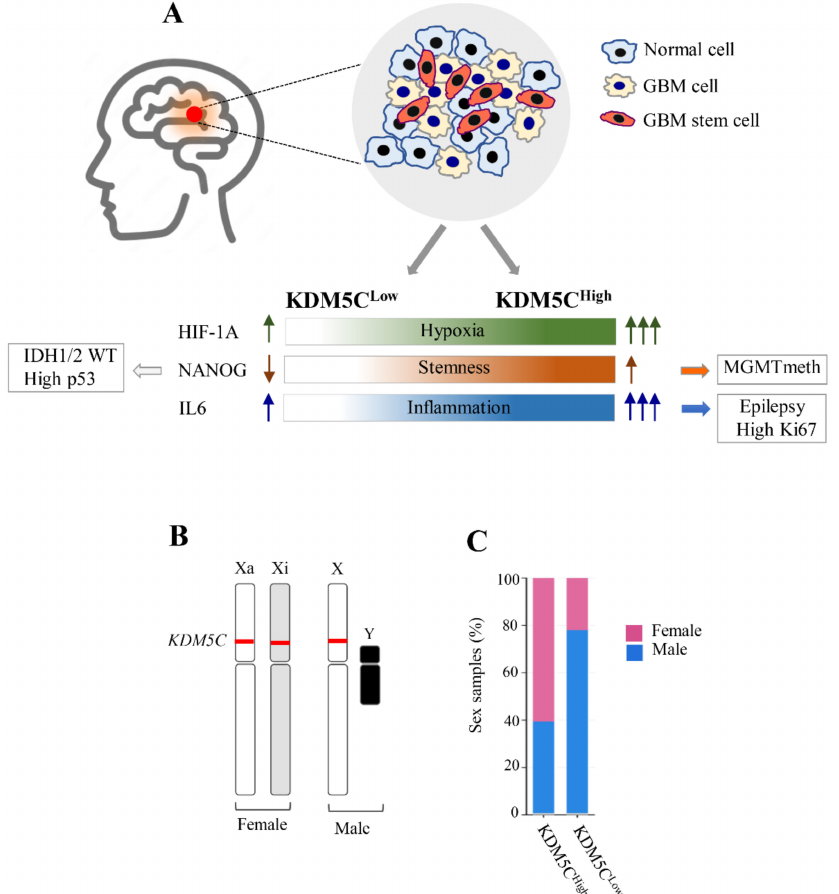
Figure 7. Molecular features of GBM patients stratified by expression data of the chromatin oxygen sensor gene KDM5C . ( A ) High expression levels of the tumor markers HIF1A , NANOG , and IL6 are associated with a high level of KDM5C . ( B ) KDM5C expression variability in female and male individuals. Since KDM5C escapes X-inactivation, two active alleles (in red) are present in female individuals, unlike the male individuals, in which only one allele drives the expression of KDM5C . ( C ) Sex-related distribution in the KDM5C High and KDM5C Low GBM subgroups identified in TCGA. Xa, X chromosome active; Xi, X chromosome